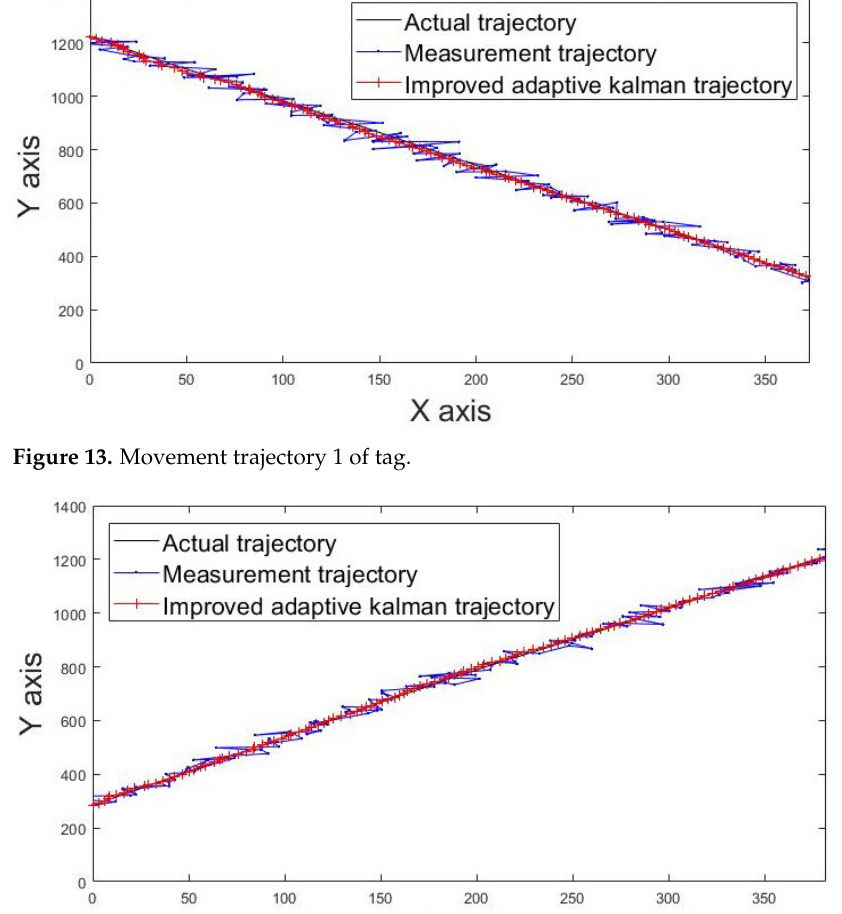
Figure 12. Experimental environment diagram of dynamic interference point shifting error analysis. The actual movement trajectories 1 and 2 of the static tag are shown in Figures 13 and 14. The blue line indicates the movement trajectory of the original measurement. The red line shows the improved movement trajectory achieved using the IAKF algorithm; the red line is closer to the ideal trajectory shown by the black line, thus indicating that the IAKF al- gorithm successfully tackles the dynamic positioning point shifting problem.